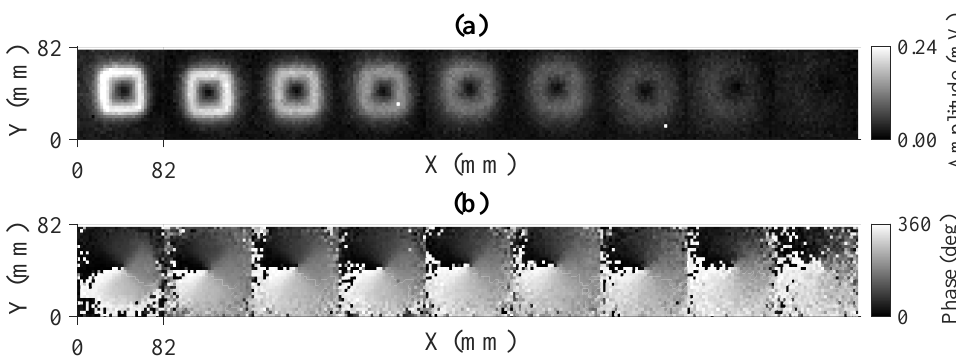
Figure 6. Plots of the amplitude ( a ) and phase ( b ) of measured rf signals generated by scans over the 40 × 40mm 2 , 2mm thick ferrite plate for lift-off’s of 1.5mm, 3mm, 4mm, 6mm, 8mm, 10mm, 13mm, 16mm, and 25mm. The images were recorded at an operating frequency of 29kHz.